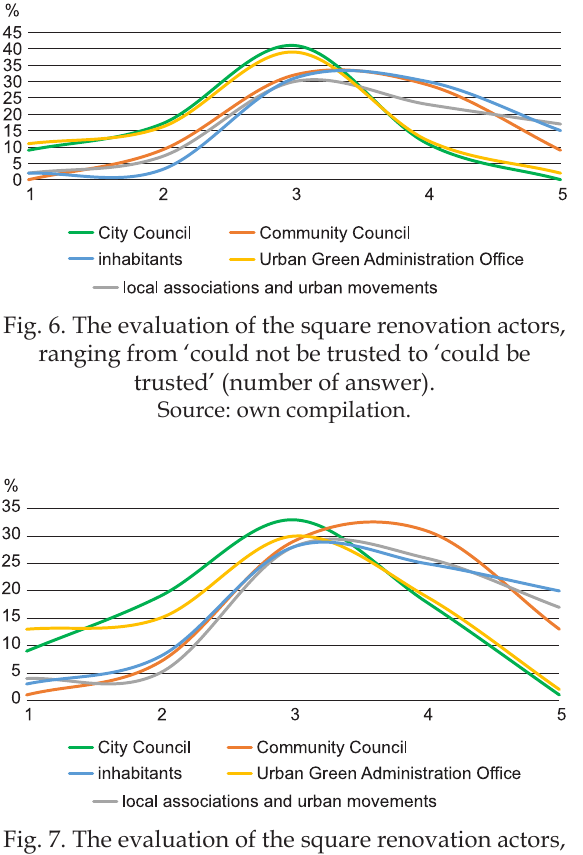
Fig. 7. The evaluation of the square renovation actors, ranging from ‘not caring about common good’ to ‘caring about common good’ (number of answer). Source: own compilation.